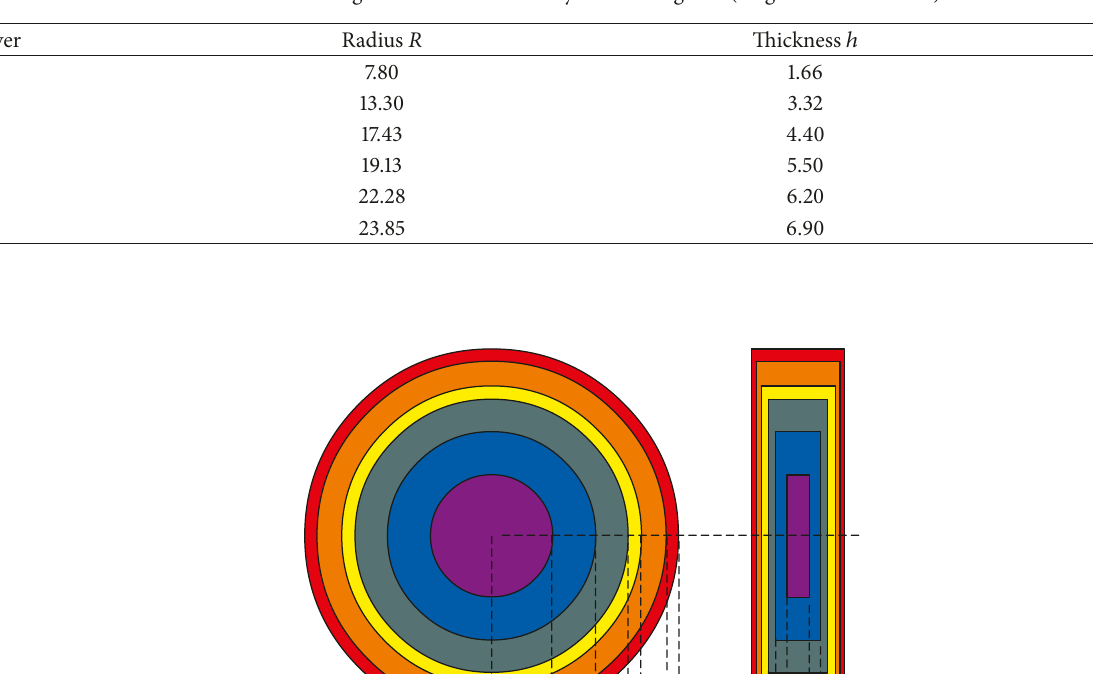
Table 1: Design Parameters for six-layer Luneburg lens (lengths in millimetres).